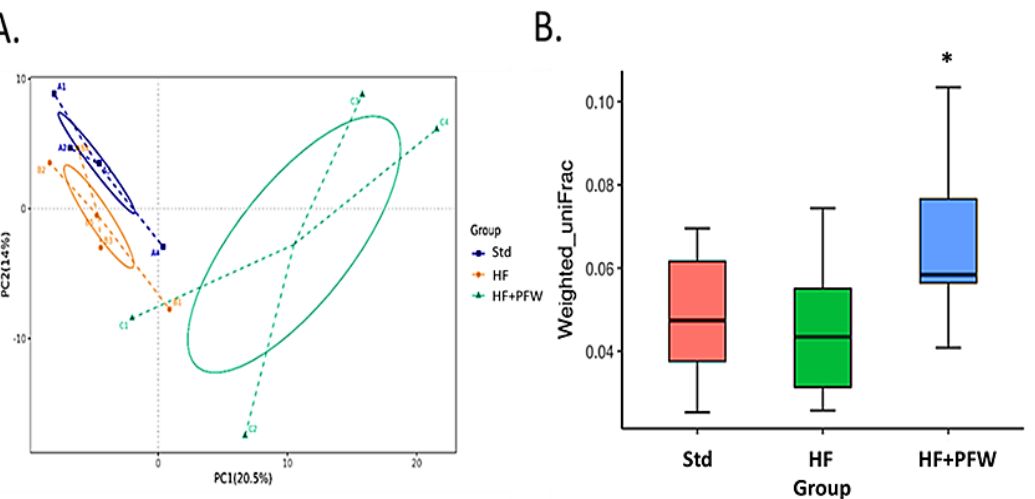
Figure 4. The effect of PFW on gut microbiota distribution in mice fed a high-fat diet. ( A ) Principal components analysis (PCA) was used to determine the beta diversity of gut microbiota. Samples with more similar composition cluster closer together. ( B ) Beta diversity of the community was cal- culated by using the UniFrac distance matrix. * p < 0.05 compared with the Std group. Group Std, standard diet; group HF, high-fat diet; group HF+PFW, high-fat diet plus PFW treatment.